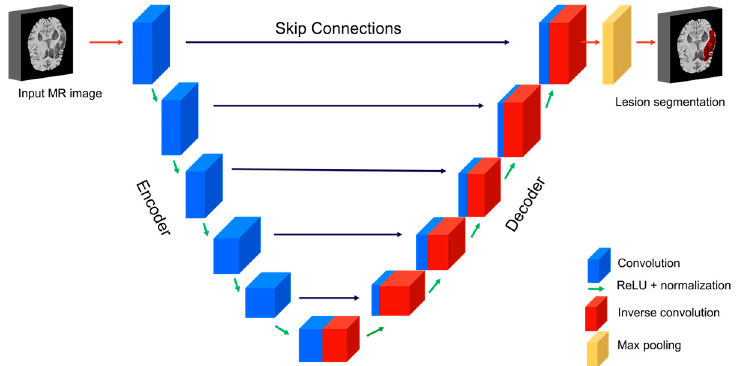
Figure 2. Schematic representation of 3D-UNet architecture.